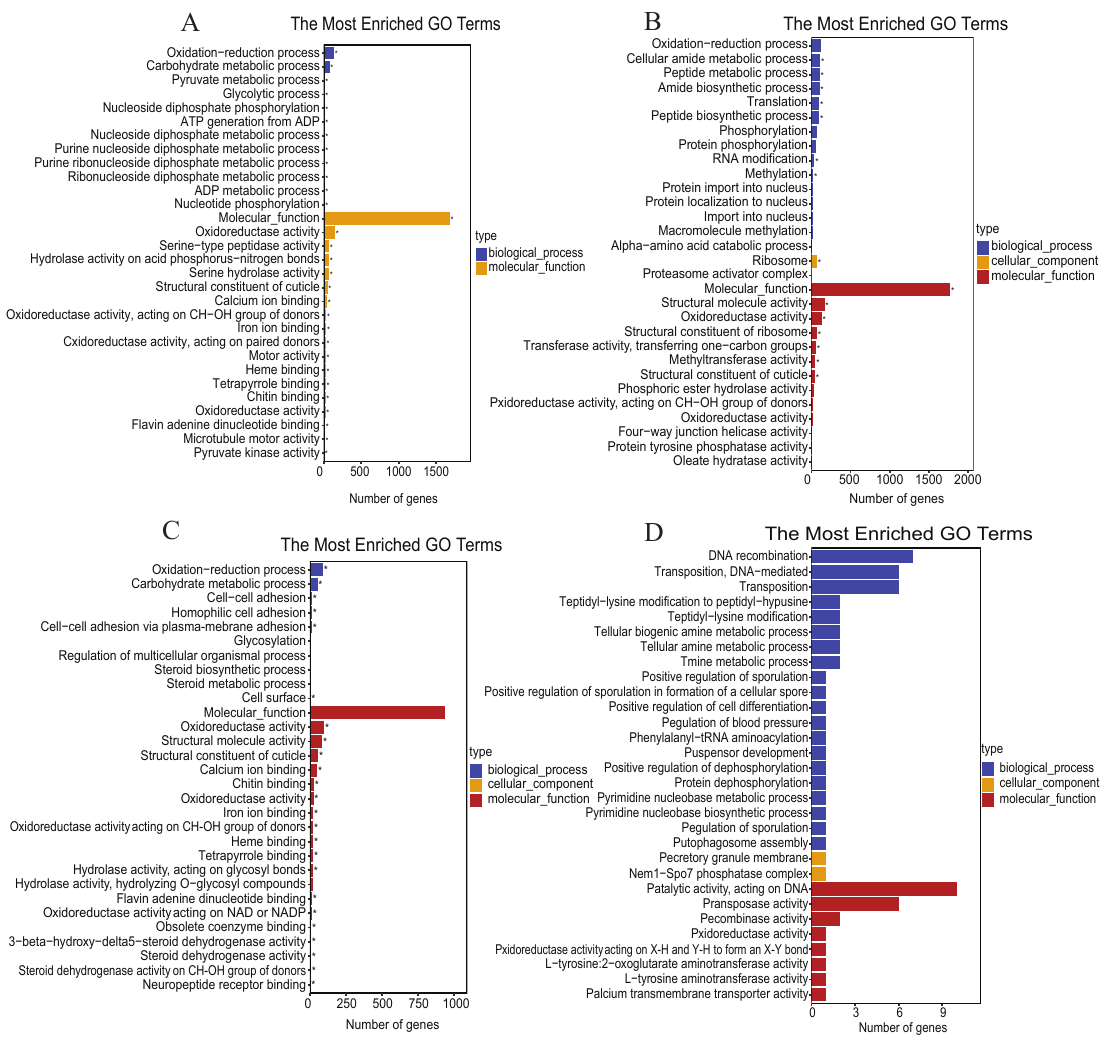
Figure 3. Gene ontology (GO) categories of S. furcifera DEGs after challenge with M. anisopliae at different periods. ( A ) GO categories of S. furcifera DEGs after challenge with M. anisopliae at 24 h vs. 0 h; ( B ) GO categories of S. furcifera DEGs after challenge with M. anisopliae at 24 h; ( C ) GO categories of S. furcifera DEGs after challenge with M. anisopliae at 48 h vs. 0 h; and ( D ) GO categories of S. furcifera DEGs after challenge with M. anisopliae at 48 h. The asterisks (*) indicate the significant enrichment of GO